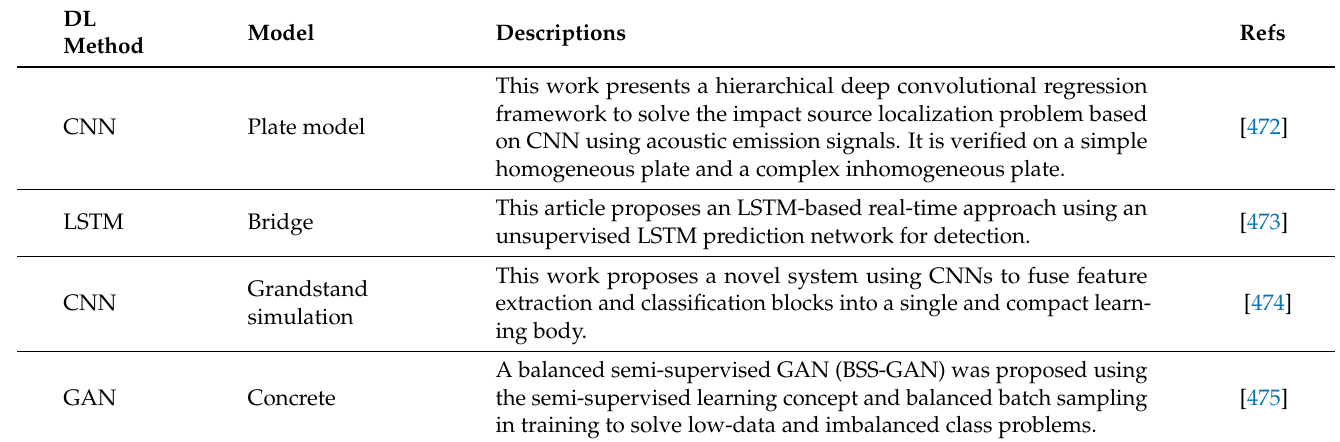
Table 28. Recent papers on DL in SHM